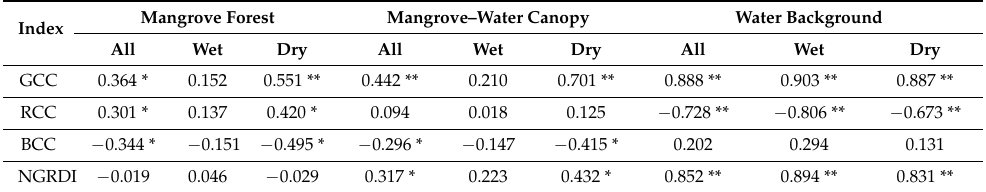
Table 2. Correlations of diurnal RGB color indices with normalized water levels. Wet is the wet season (July, October) and dry is the dry season (December,